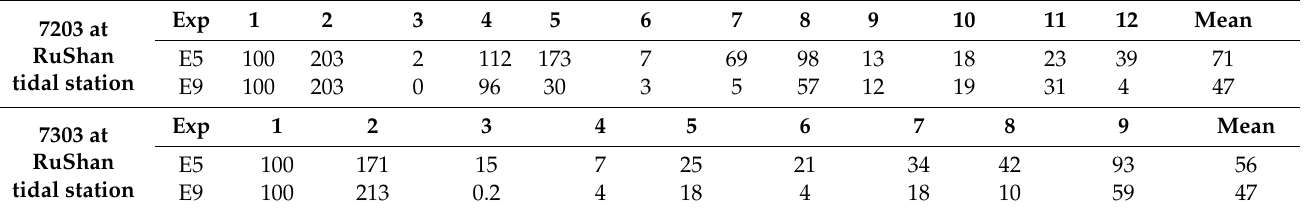
Figure 15. Storm surge levels without and with four constituents ( M 2 , S 2 , K 1 , O 1 ) in E5 and E9 respectively, observation (black line), total level of combination with the astronomical tide and storm surge (cyan line) ( top ), and their differences ( bottom ) during Typhoon 7303 at RuShan station. Table 11. Relative errors between simulated and observed storm surge levels at RuShan tidal station in each 6-hour period during Typhoons 7203 and 7303 (unit: